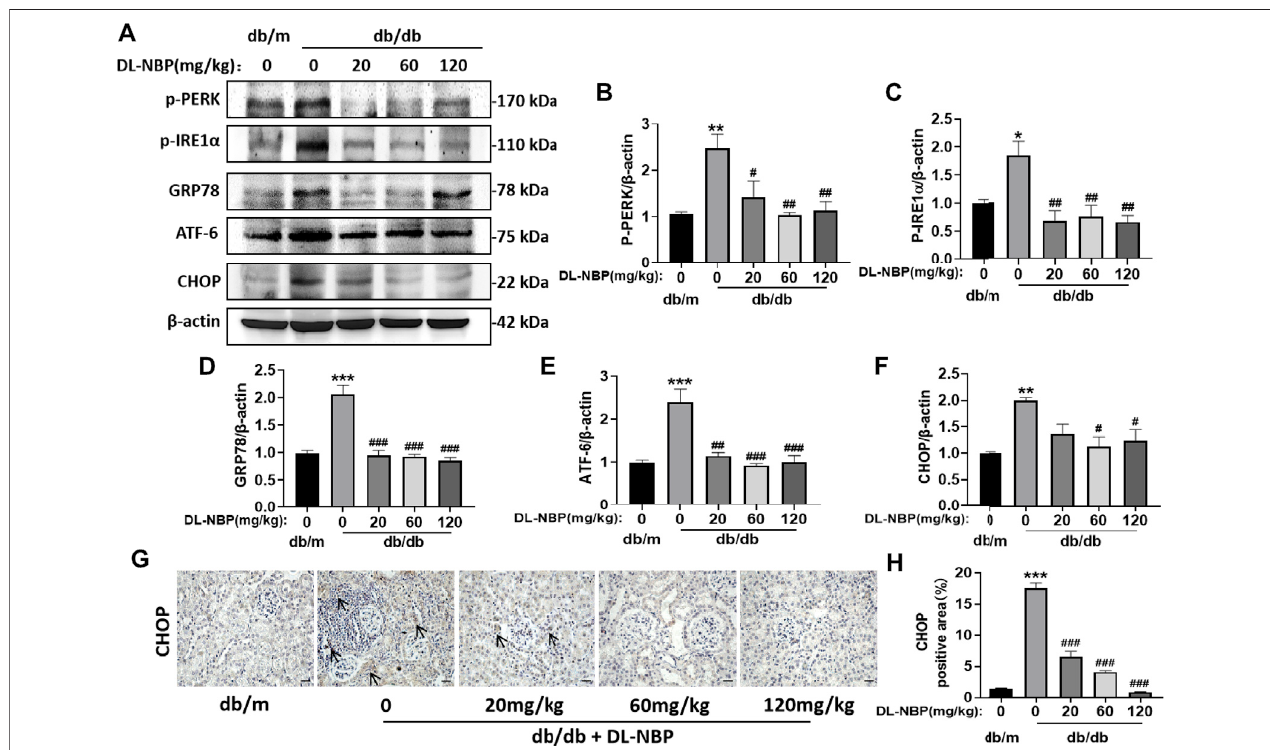
FIGURE6| DL-NBP treatmentinhibitsdiabetes-induced elevated ERSinkidney. (A – F) Western blotting andquanti fi cation ofERS-elevatedprotein expression [p- PERK (A,B) , p-IRE1 α (A,C) , GRP78 (A,D) , ATF-6 (A,E) , CHOP (A,F) ] in kidney of mice from each group ( n (cid:2) 3). Protein expression was normalized to the expression of β -actin. (G,H) Representative images of immunohistochemical staining of CHOP in kidney of mice from each group ( n (cid:2) 3). Scale bar (cid:2) 20 μ m. Data are presented as mean ± SEM; * p < 0.05, ** p < 0.01, *** p < 0.001 vs . db/m control; # p < 0.05, ## p < 0.01, ### p < 0.001 vs. db/db mice.